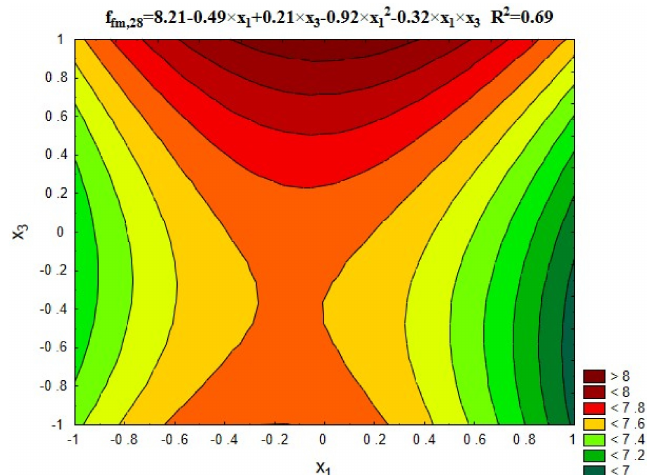
Figure 5. Changes in flexural strength of concrete depending on x 1 and x 3 (x 2 =